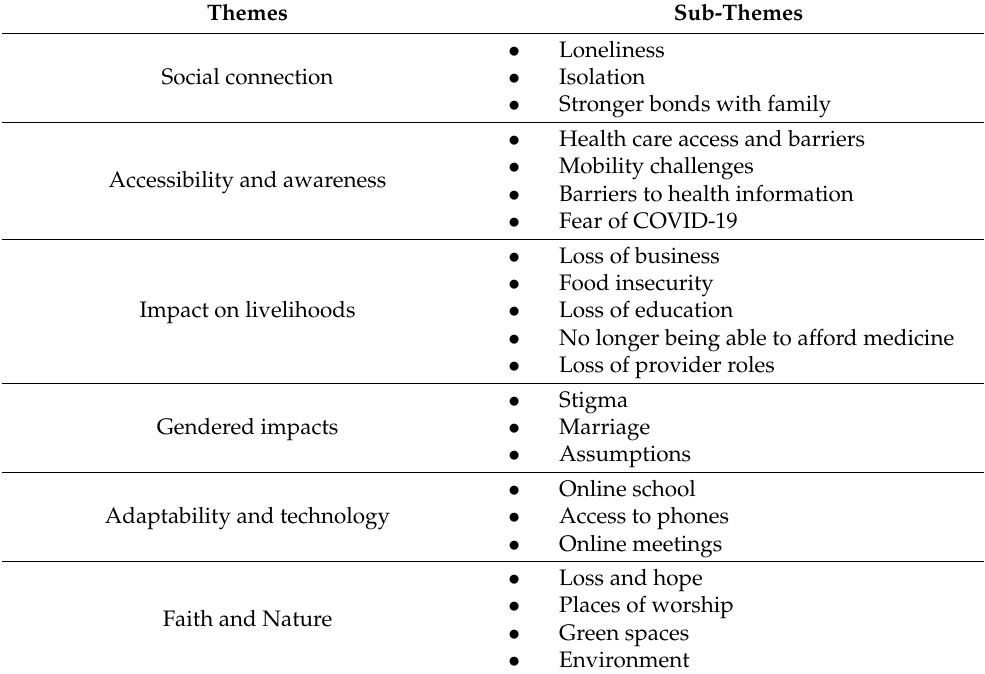
Table 2. Table of themes